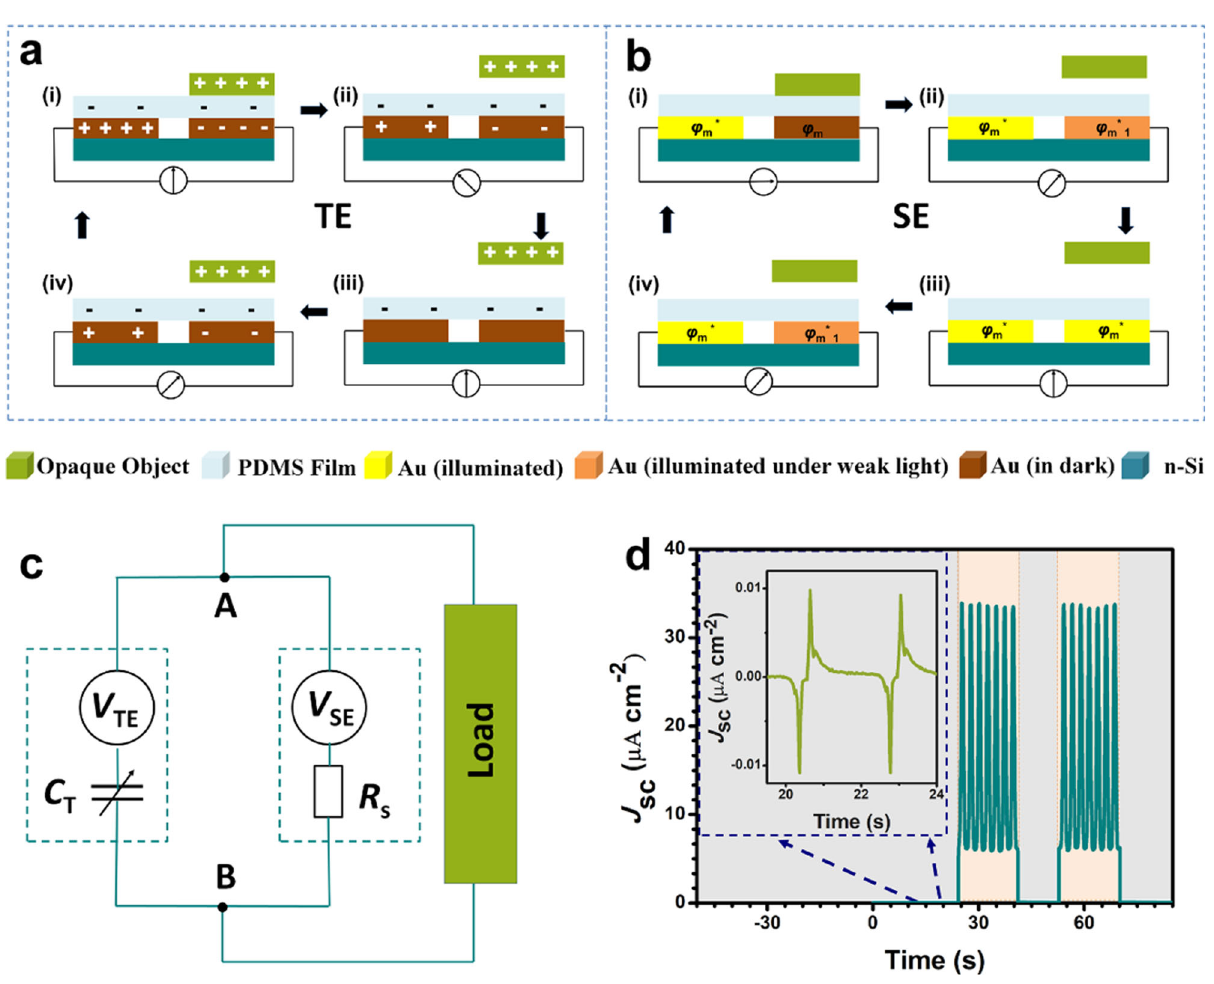
Fig. 3 Working principle and typical output of the shadow-tribo-effect nanogenerator (S-TENG). Step-by-step illustration showing the a tribo-effect (TE) and b shadow-effect (SE) working principle of the S-TENG under dark and illumination conditions. c Equivalent circuit model of S-TENG hybrid TE and SE. d short-circuit current density ( J sc ) of the S-TENG in dark and illumination by moving stage of force gauge up and down. Inset is the details of the output performance from 19.5 s to 24